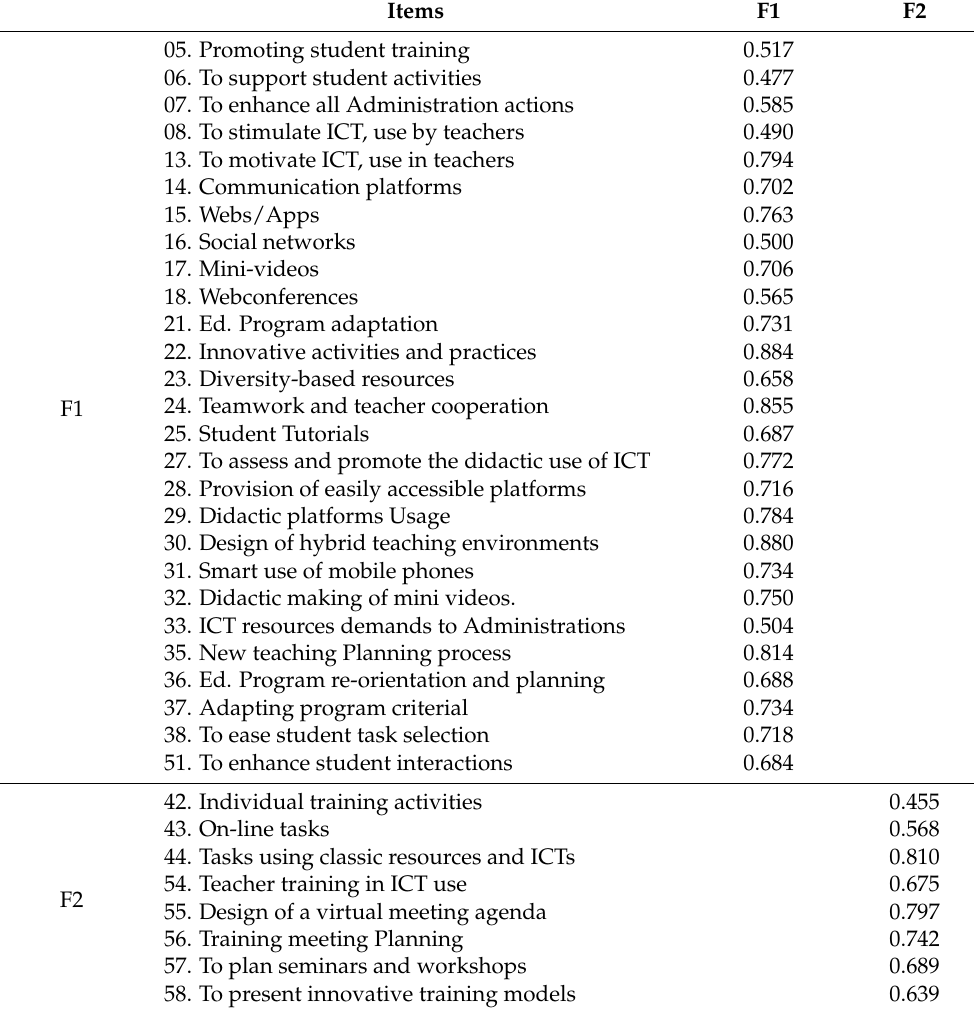
Table 6. Results of factorial analysis: